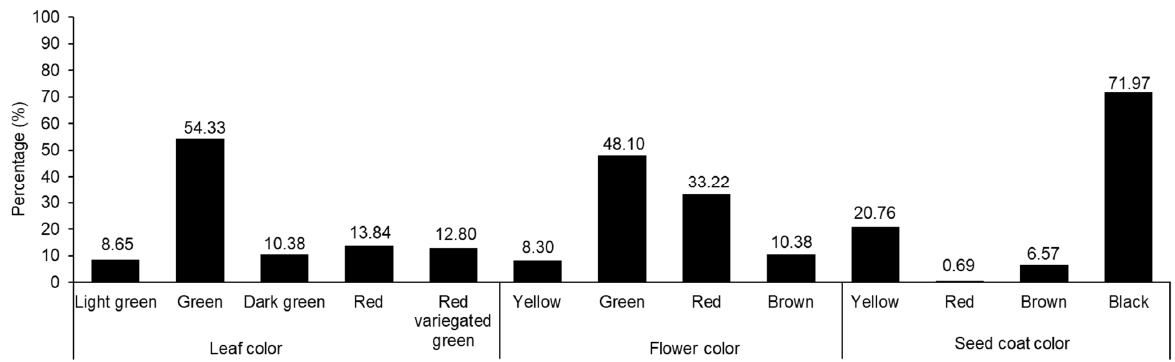
Figure 1. Percentage distributions of amaranth accessions based on the morphological characters of leaf, flower, and seed coat colors.